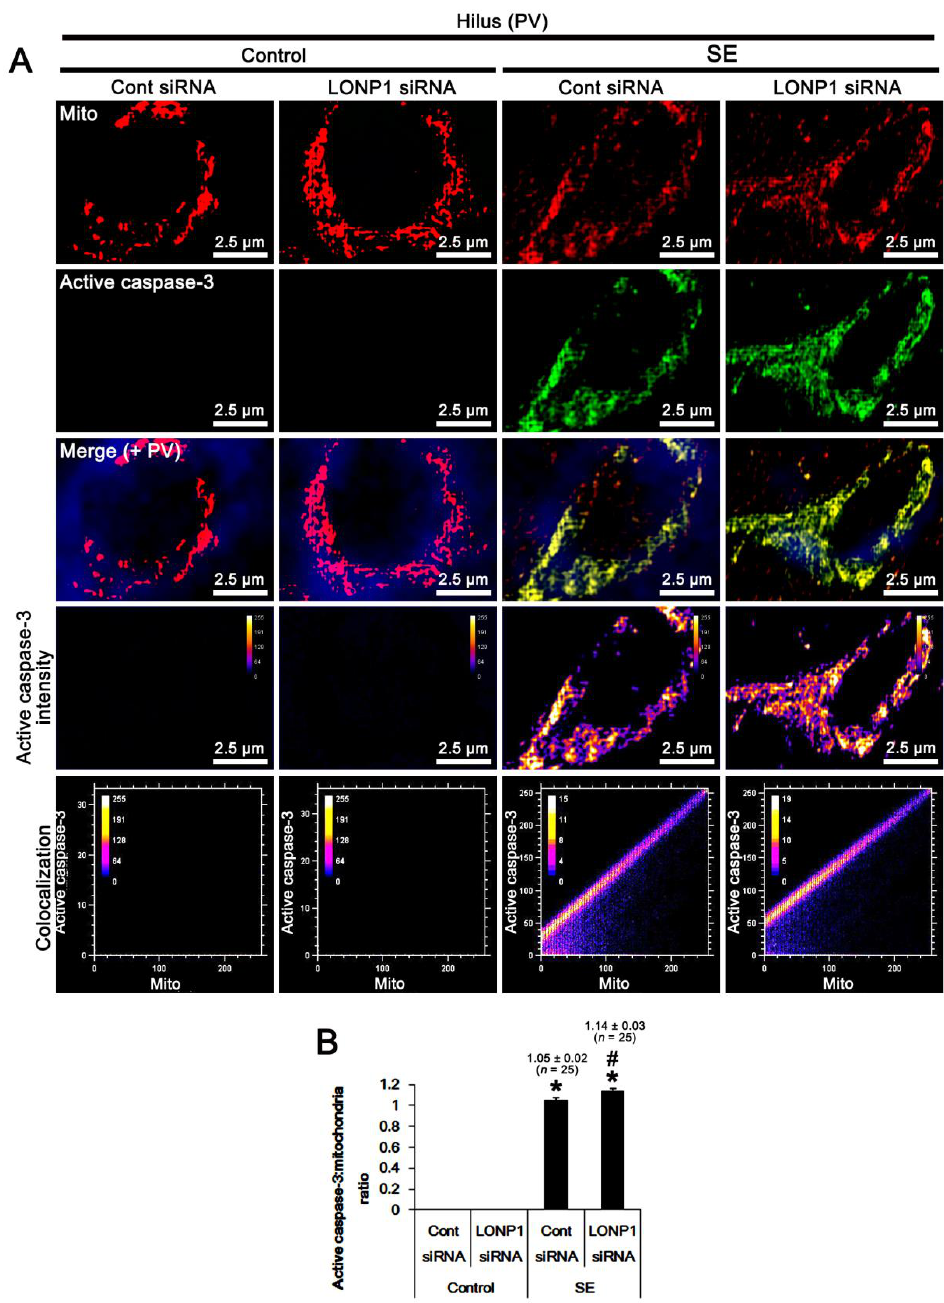
Figure 7. Effects of control siRNA and LONP1 siRNA on mitochondrial accumulation of active caspase-3 in PV neurons following SE. As compared to control siRNA (Cont siRNA), LONP1 siRNA increases mitochondrial accumulation of active caspase-3 following SE. ( A ) Representative photos of active caspase-3 level, intensity, and the degree of colocalization in mitochondria within PV cells. ( B ) Quantification of the active caspase-3/mitochondria ratio (the degree of colocalization) following SE (mean ± S.E.M.; * ,# p < 0.05 vs. control animals and control siRNA, respectively; one-way ANOVA).